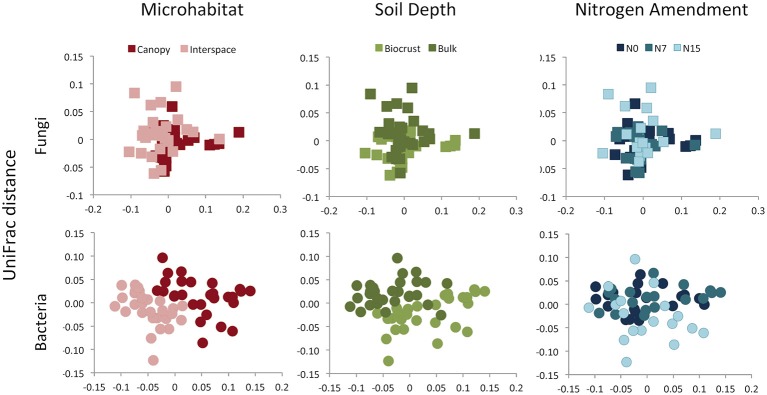
Community composition (UniFrac distance) of fungal or bacterial communities, displayed as 2D MDS plots. Plots are color coded to show microhabitat (red), soil depth (green), or N amendment (blue) differences. See Results text for statistical support.